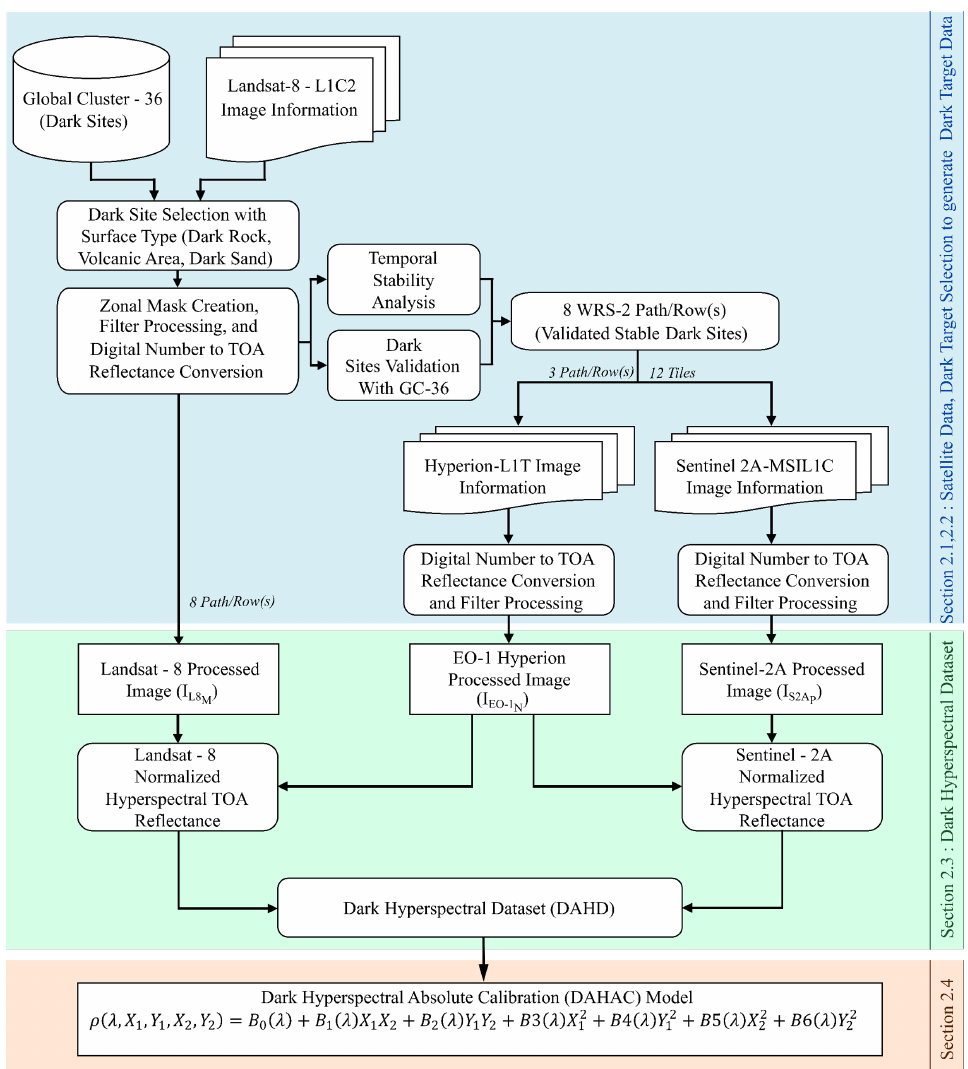
Figure 1. Flowchart showing study area selection and sensor pre-processing for the DAHAC model’s